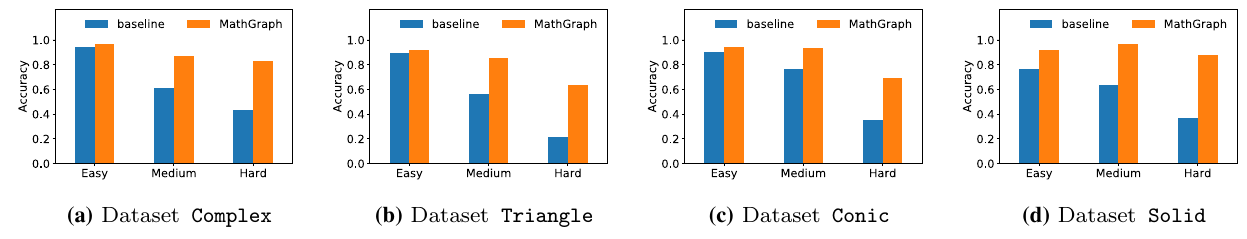
Fig. 8 Accuracy on different difficulty